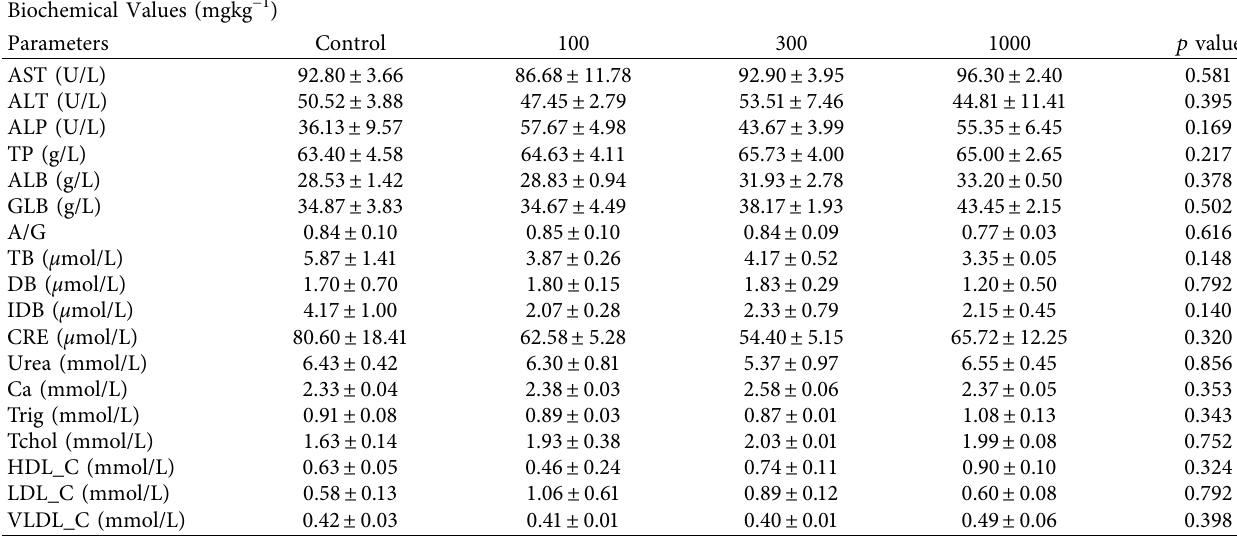
Table 2: Serum biochemical indices in animals orally dosed with the AAE in the subacute toxicity tests. Biochemical Values (mgkg − 1 )